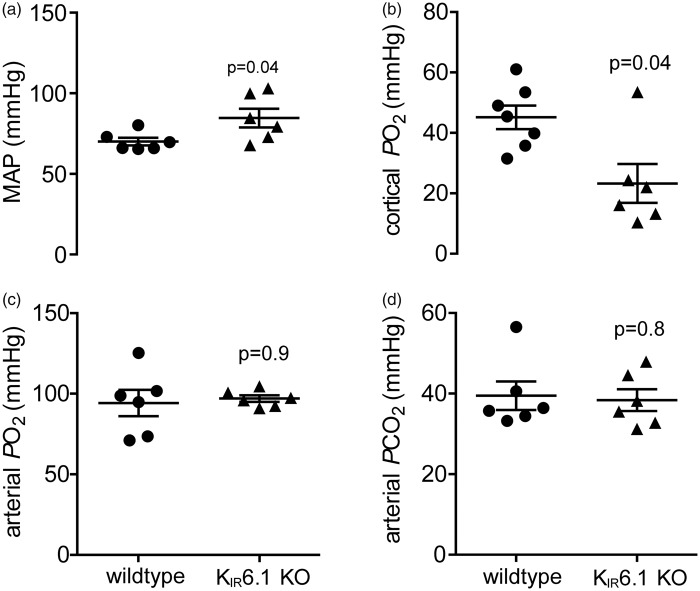
Reduced parenchymal partial pressure of oxygen (PO2) in the visual cortex in mice lacking KATP channel subunit KIR6.1. Summary data illustrating mean arterial blood pressure (MAP) (a) resting brain tissue PO2 (b), arterial PO2 (c), and arterial PCO2 (d) in KIR6.1 knockout (KO) and wildtype mice. Data are presented as individual values and means ± SEM.